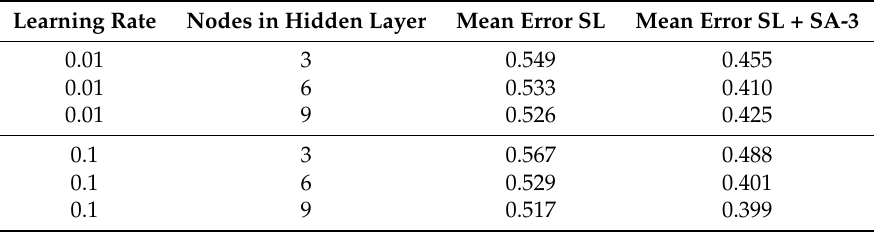
Table 4. Prediction Mean Error (top ANN configuration) for DMA SL and for DMA combination SL +